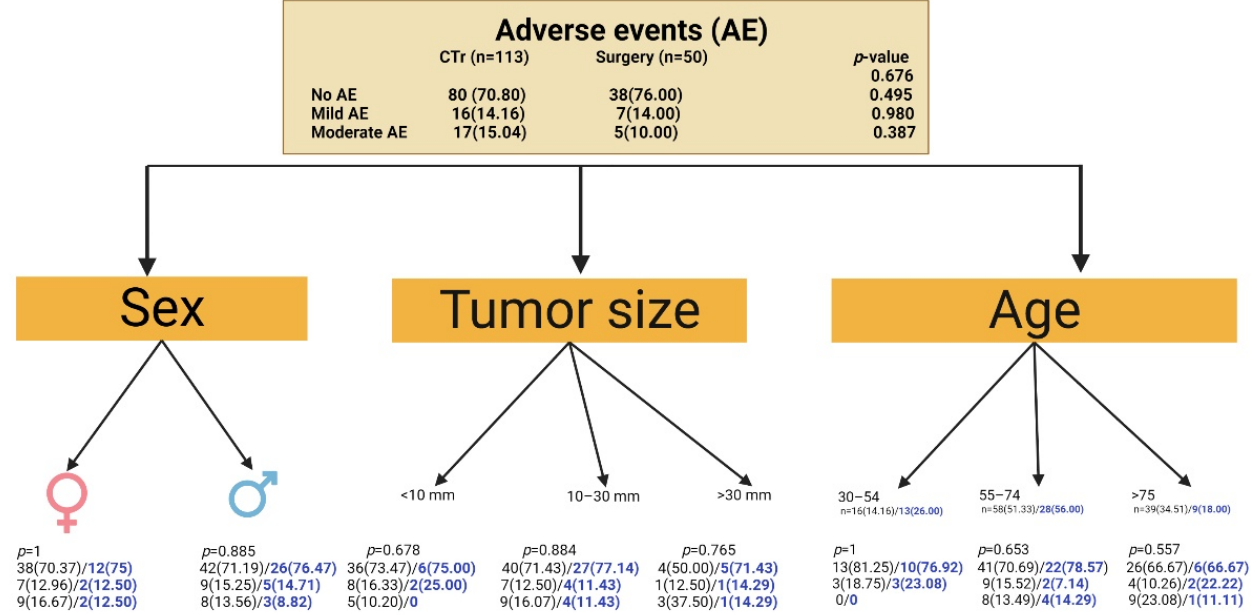
Figure 4. Adverse events (local pain and pruritus) experienced in treatment subgroups. The numbers in brackets represent the percentages with respect to the cardinal of the group. (Surgery with blue).